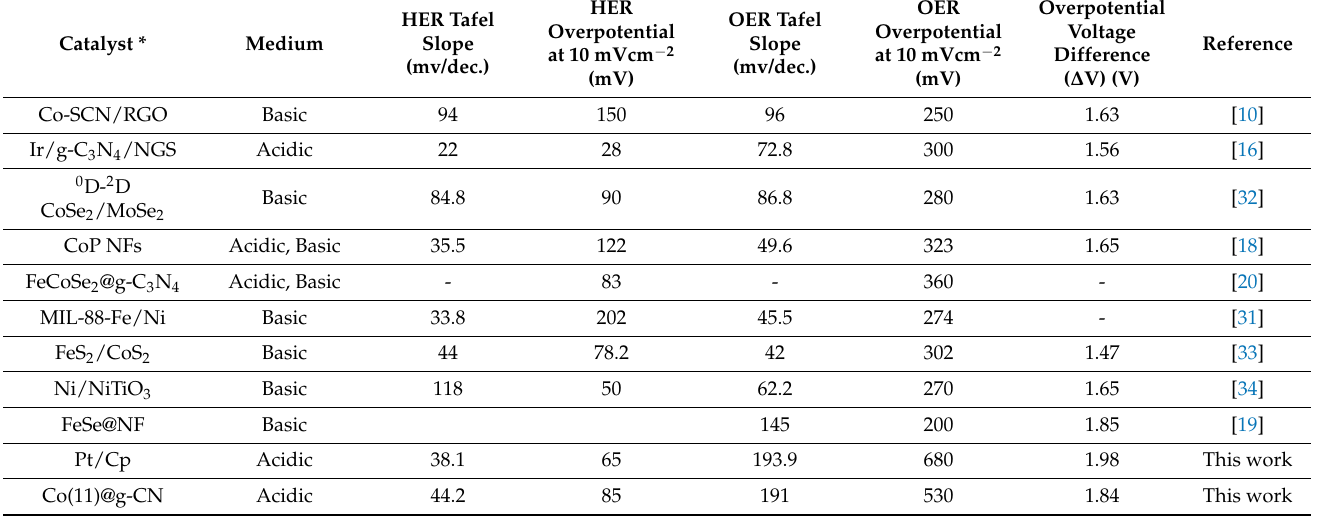
Table 3. Parameters of electrochemical water splitting by bifunction